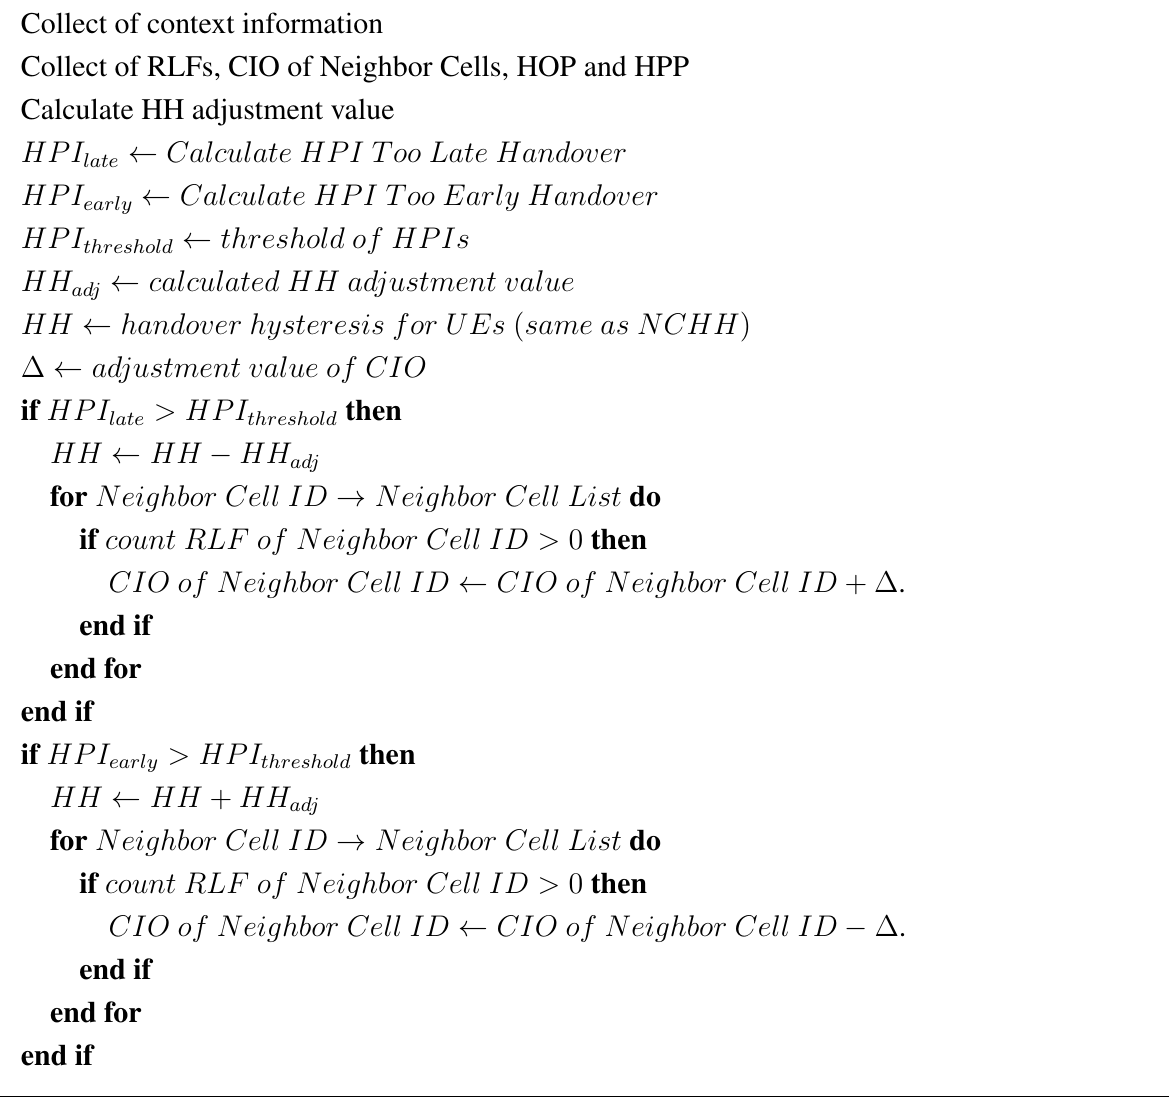
Algorithm 1 Proposed HO parameter optimization